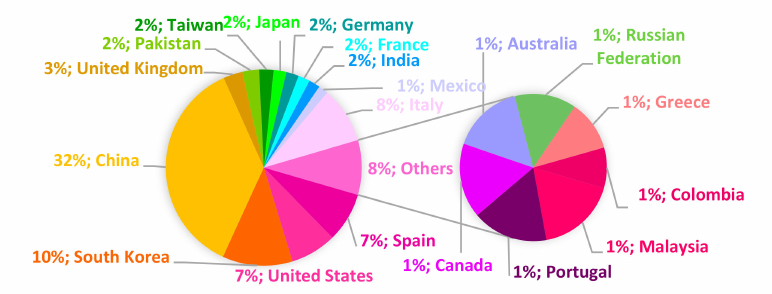
Figure 25. Distribution of authors for the 20 countries that show the highest participation (87.29% of the global) in the journal Electronics. Data referenced to global data from 87 countries.